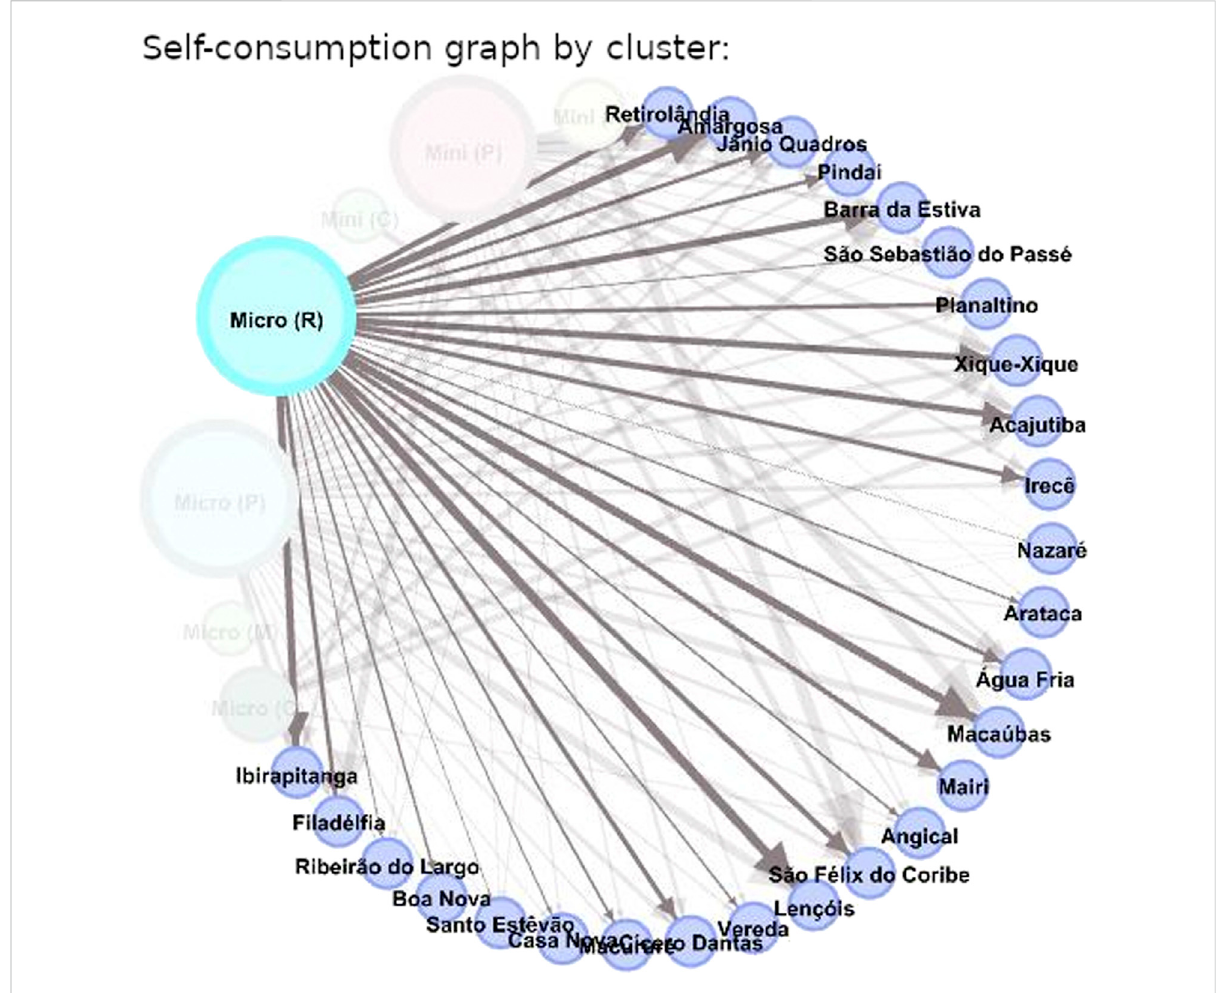
FIGURE 8 List of municipalities that identify the clusters found in each